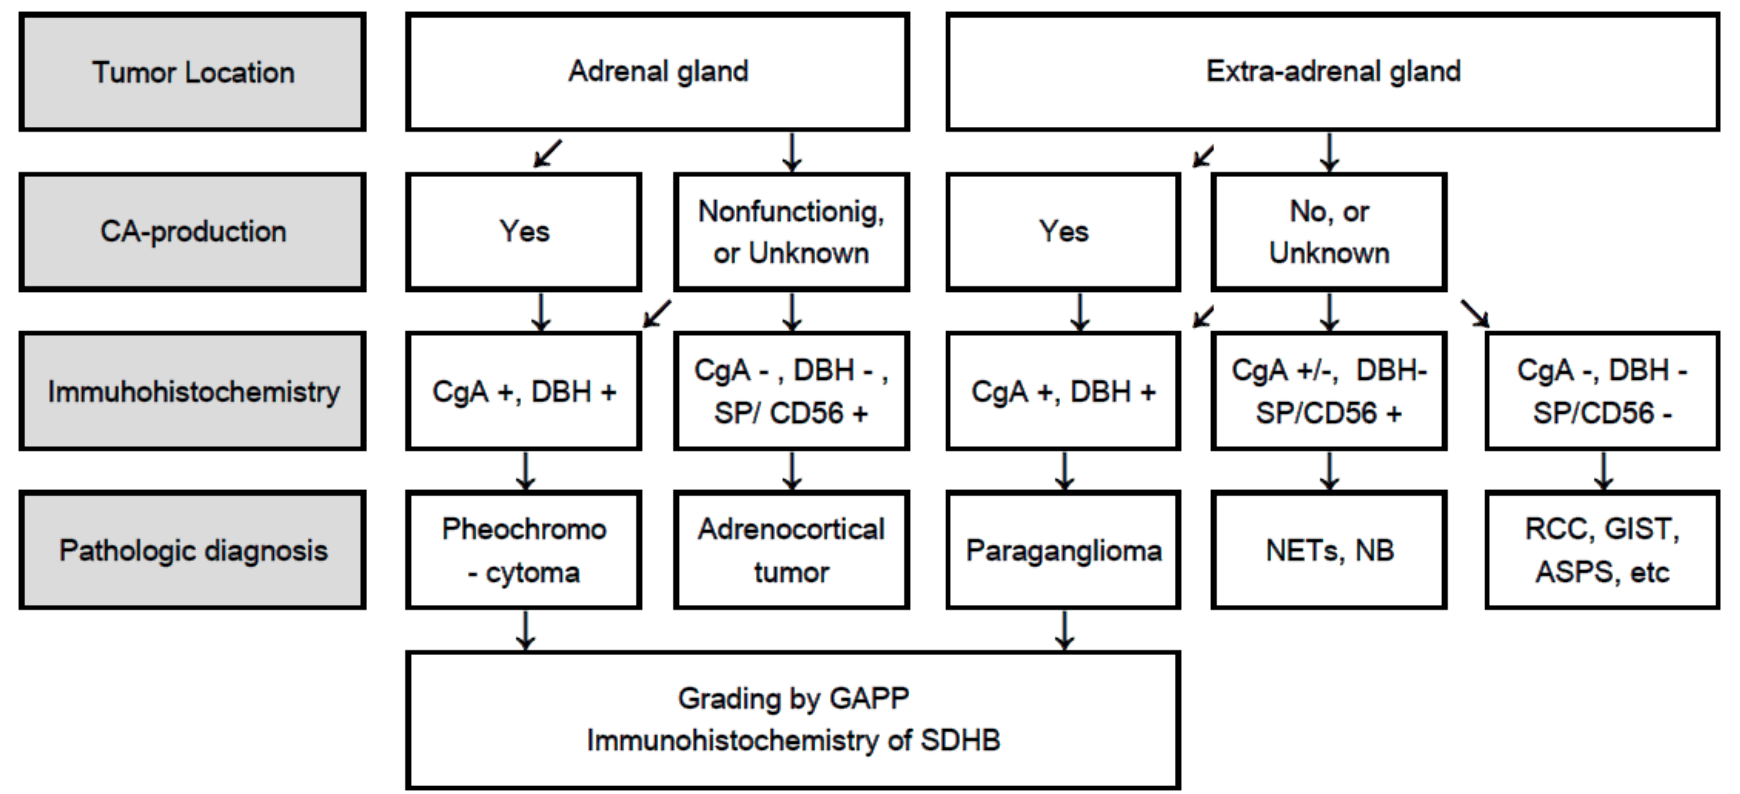
Figure 2. Flowchart for differential diagnosis of PPGLs based on tumor location, catecholamine production, and immunohistochemistry. CA: Catecholamine; CgA: Chromogranin A; DBH: Dopamine β -hydroxylase; SDHB: Succinate dehyrogenase subunit B; PCC: Pheochromocytoma; PGL: Paraganglioma; GAPP: Grading of adrenal pheochromocytoma and paraganglioma; SP: Synaptophysin; CD56: Neural cell adhesion molecule; NETs: Neuroendocrine tumors; NB: Neuroblastoma; RCC: Renal cell carcinoma; GIST: Gastrointestinal stromal tumor; ASPS: Alveolar soft part sarcoma.